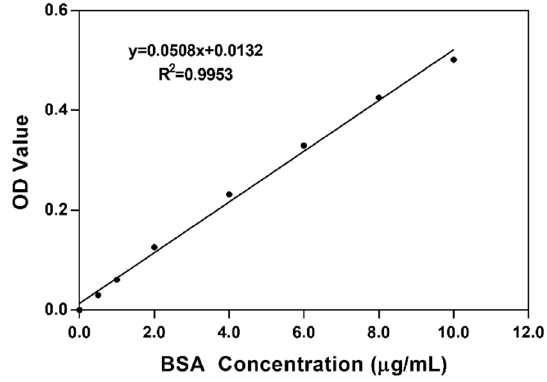
Figure 2. Standard curve of BSA. (OD: Optical Density; BSA: Bovine Serum Albumin).